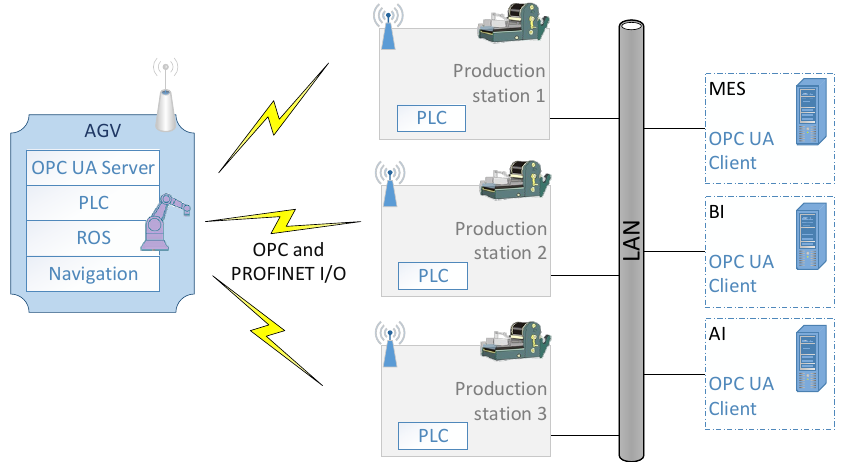
Figure 1. Industrial infrastructure with an AGV system, OPC UA and Profinet.